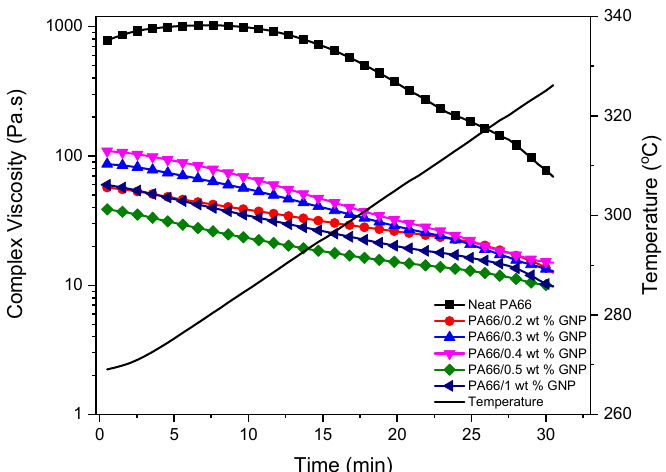
Figure 5. Change in complex viscosity with the addition of GNP to the PA66 as a function of time and temperature.